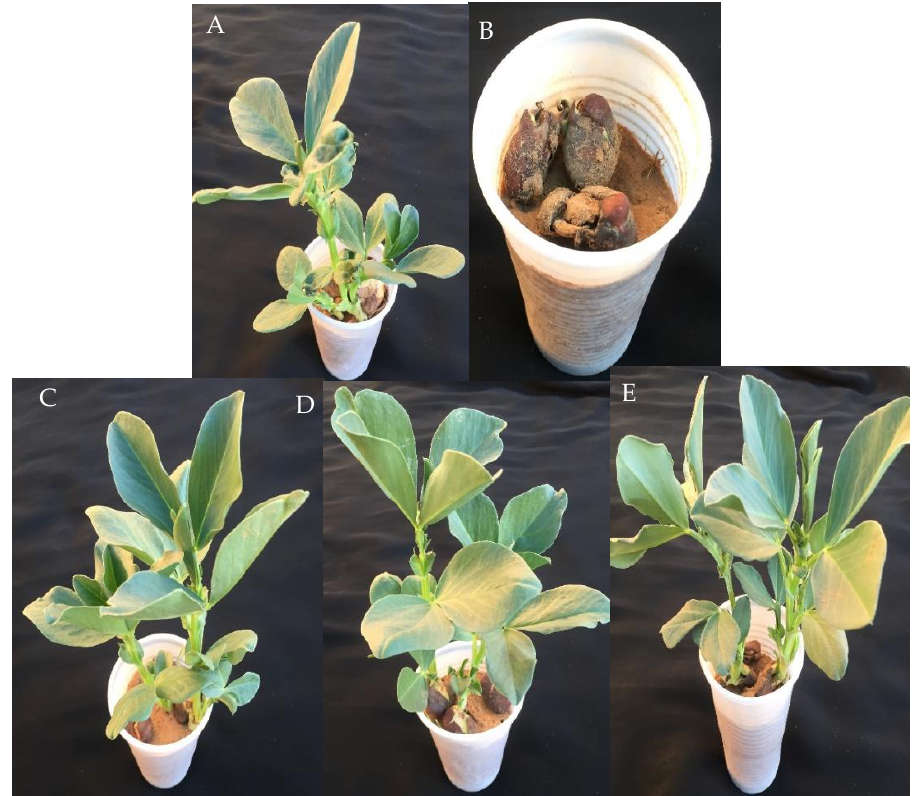
Figure 8. Effect of biocontrol agent and plant growth promotion of nano-metal complex on Vicia faba seeds germination in pots containing sandy loam soil cultivated with P. aphanidermatum . ( A ) Control seeds sown in free Pythium soil, ( B ) control seeds sown in soil infested with P. aphanidermatum , ( C – E ) and seeds sown in soil infested with P. aphanidermatum and irrigated with nano-metal complex (10, 15, 20 ppm), respectively, after 4